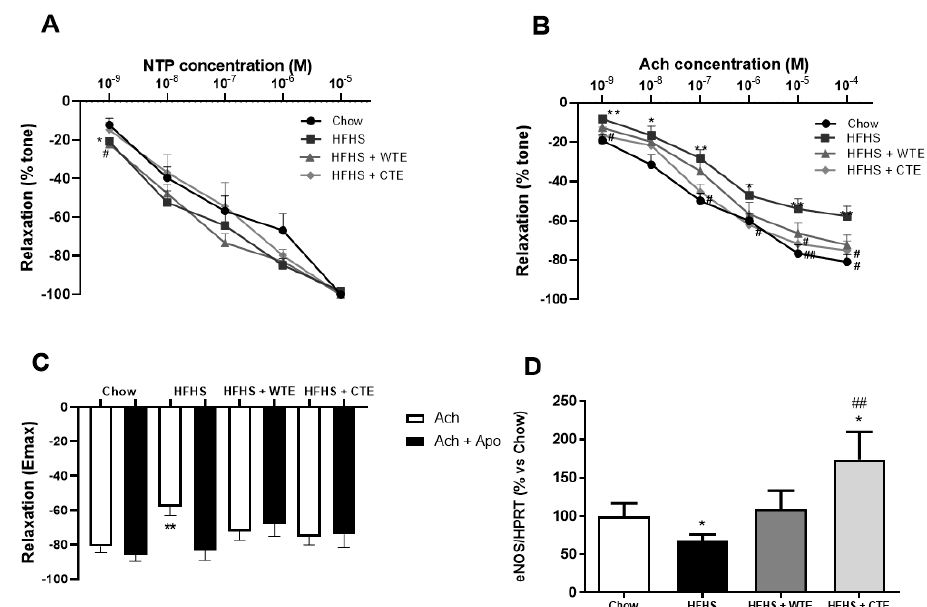
Figure 5. Relaxation of thoracic aortic segments to sodium nitroprusside (NTP) (10 − 9 –10 − 5 M) ( A ), relaxation to acetylcholine (ACh) (10 − 9 –10 − 4 M) ( B ), relaxation to acetylcholine in the presence/absence of apocynin (ACh/ACh + Apo) (10 − 6 M) ( C ), and the gene expression of endothelial nitric oxide synthase (eNOS) ( D ) of mice fed a standard diet (Chow), a high-fat diet/sucrose diet (HFHS), a high-fat diet/sucrose diet supplemented with White Tea Extract (HFHS+WTE), or a high-fat diet/sucrose diet supplemented with Tea Complex Extract (HFHS+TCE). * p < 0.05; ** p < 0.01 vs. chow. # p < 0.05 vs. HFHS; ## p < 0.01 vs. HFHS. The values are represented as the mean ± S.E.M; n = 7–10 samples/experimental group. Supplementation with both WT and CTE prevented the reduced relaxation to Ach induced by obesity ( p < 0.05 for both) and, in the case of CTE, it significantly increased the mRNA levels of eNOS ( p < 0.05). Moreover, the arterial gene expression of eNOS was not different between obese mice supplemented with WTE and control mice. Finally, despite